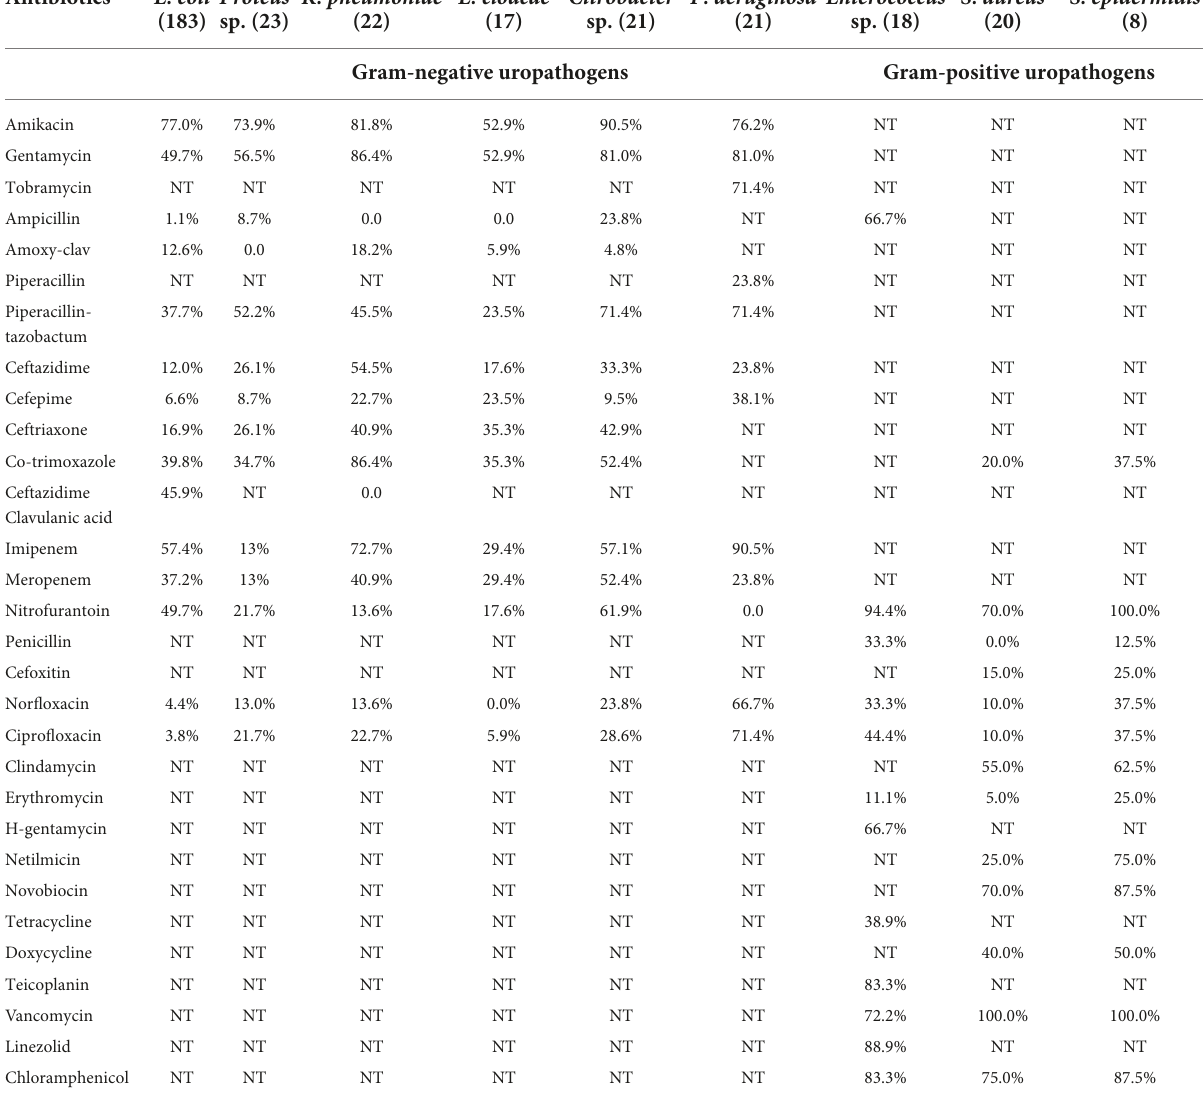
TABLE 4 Susceptibility of different antibiotics against isolated gram-negative and gram-positive uropathogens.